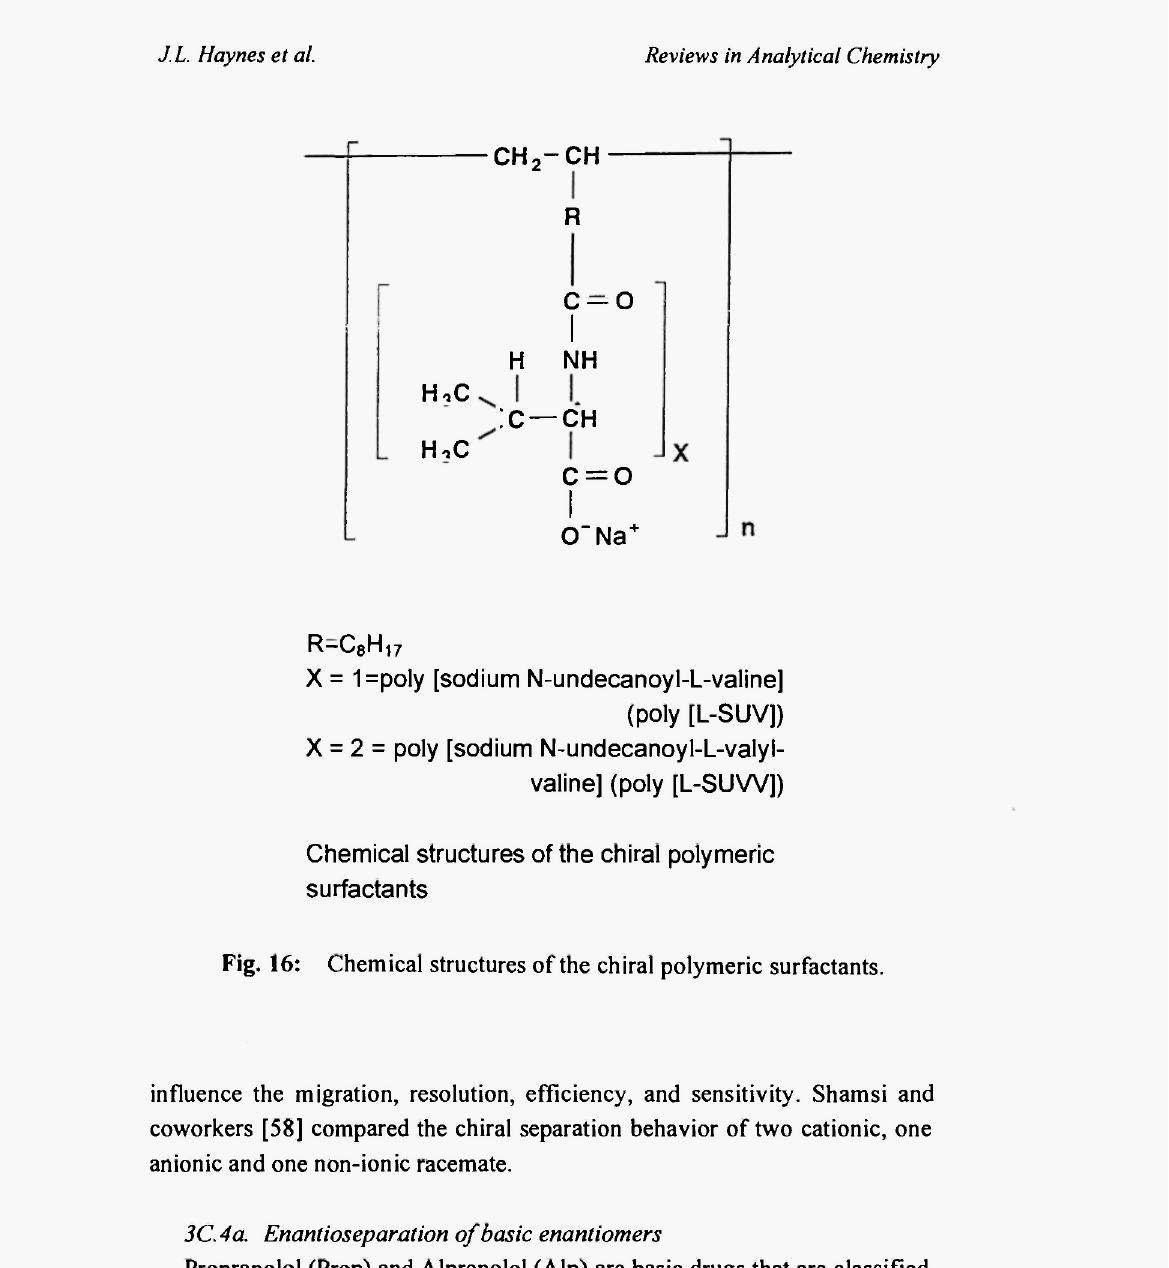
influence the migration, resolution, efficiency, and sensitivity. Shamsi and coworkers [58] compared the chiral separation behavior of two cationic, one anionic and one non-ionic racemate. of basic enantiomers Propranolol (Prop) and Alprenolol (Alp) are basic drugs that are